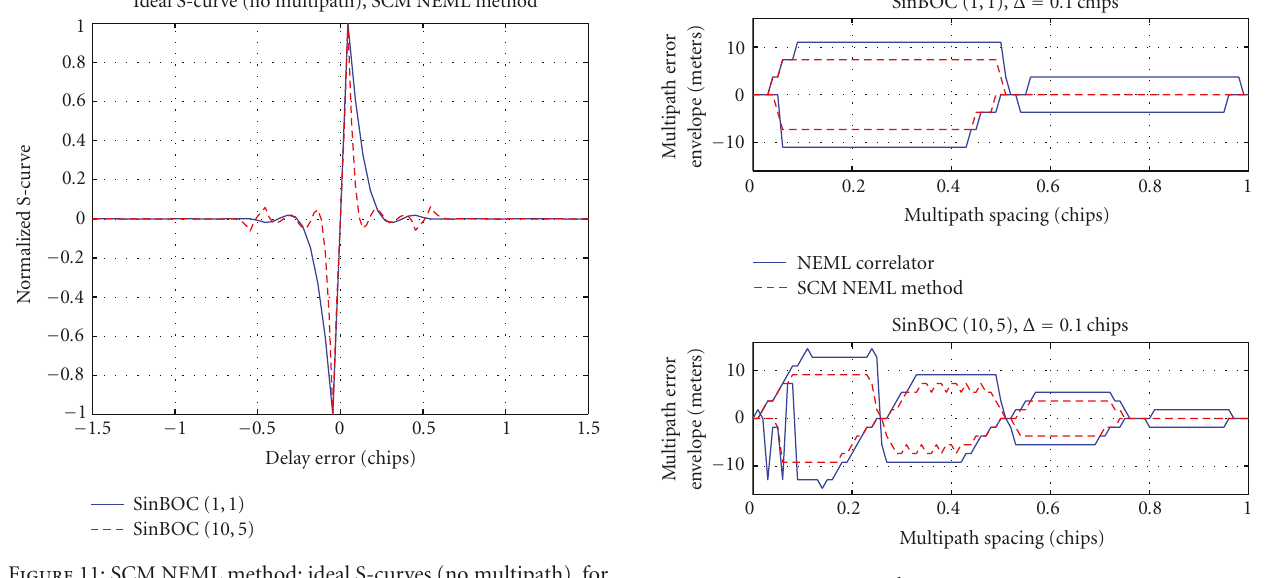
Figure 11: SCM NEML method: ideal S-curves (no multipath), for two BOC-modulation cases and Δ = 0 . 1 chips.